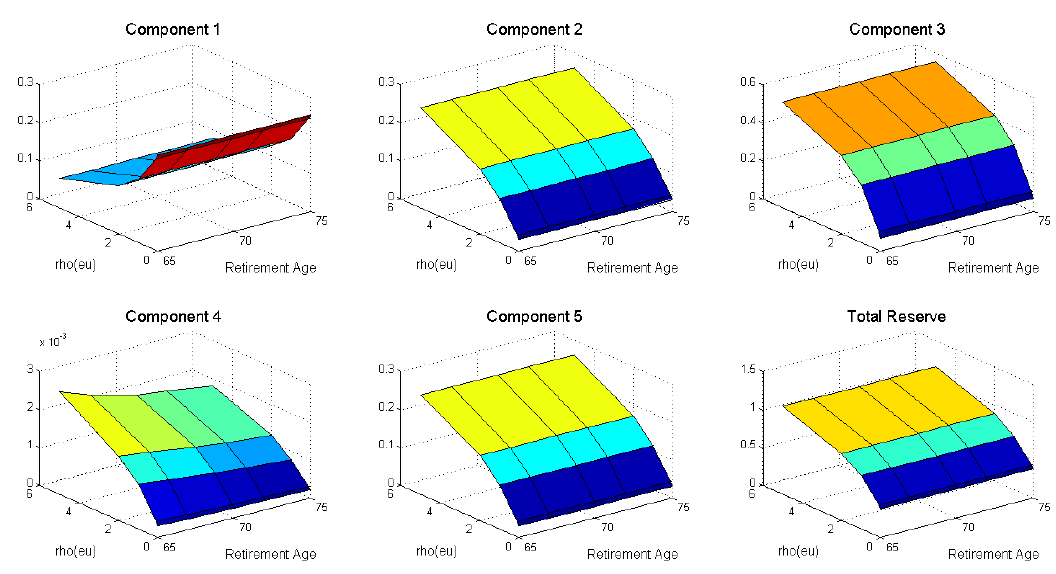
Figure 6. Sensitivity analysis with respect to ρ ( eu ) by components and total reserves.